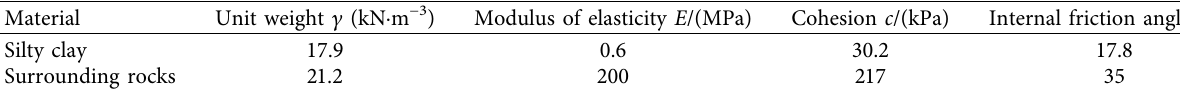
Table 6: Similar physical parameters of the foundation material model.